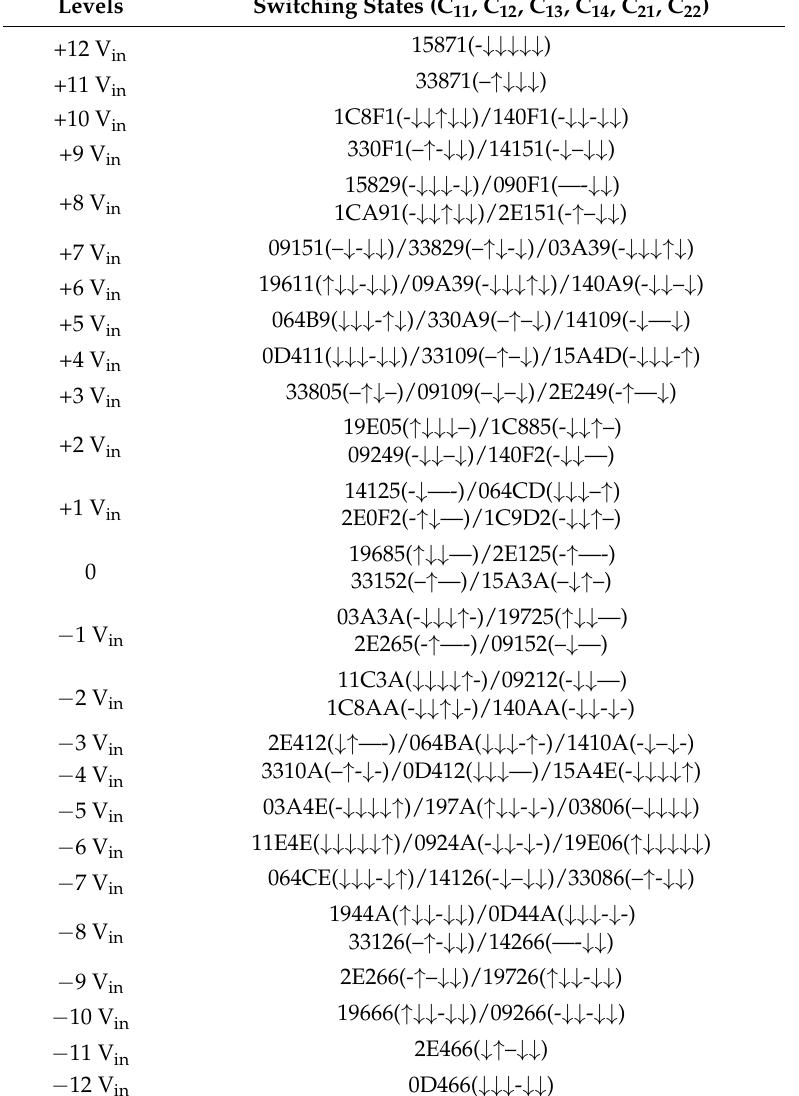
Table 1. Selected switching states for charge and discharge of the capacitors (state of